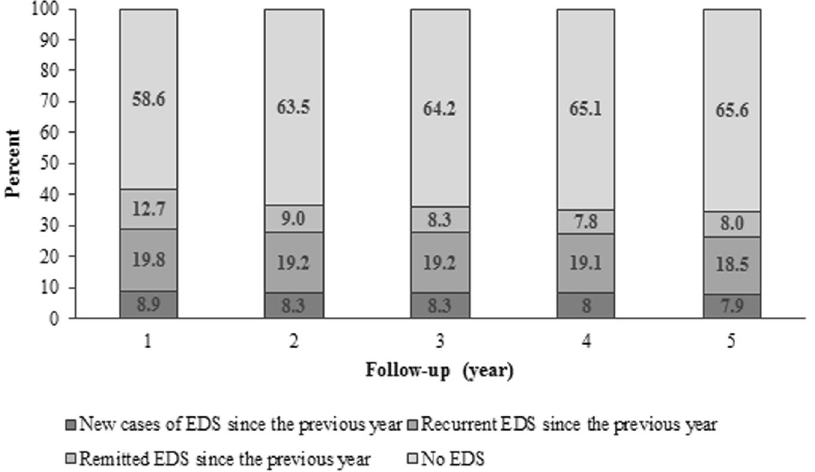
Figure 2. Prevalences of new, recurrent and remitted cases of excessive daytime sleepiness (EDS) during the